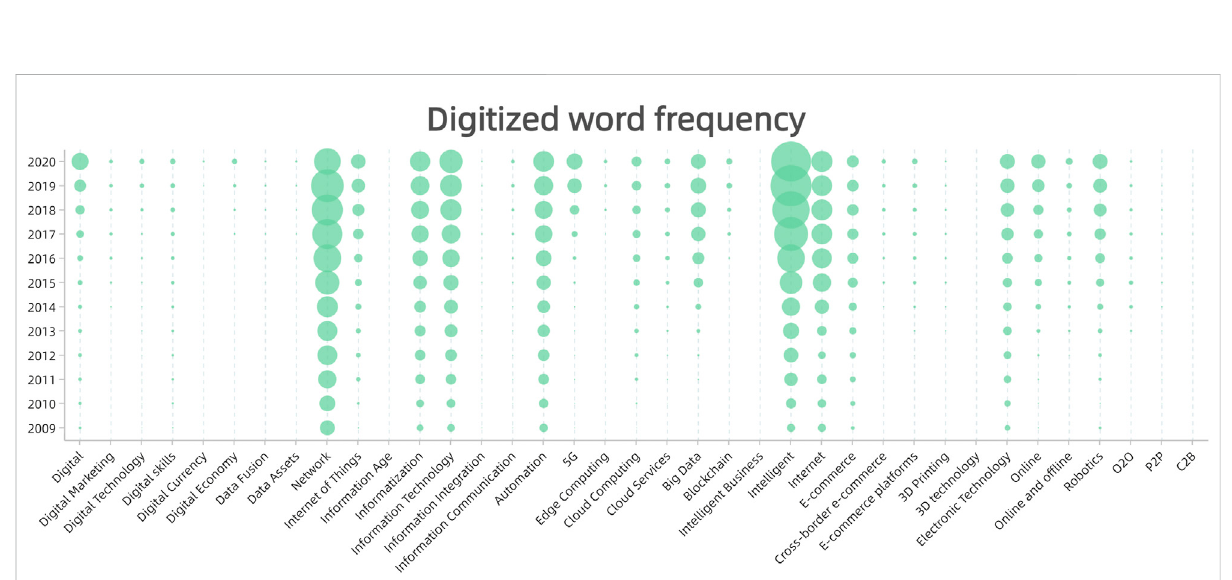
FIGURE 1 Digitized word frequency